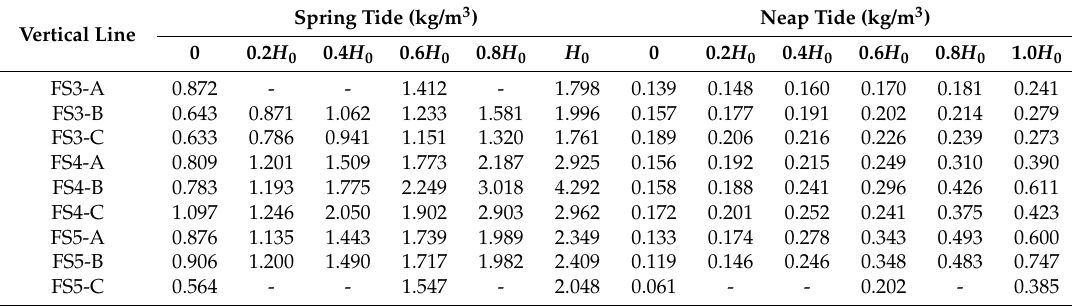
Table 3. Time-averaged sediment concentration ( S i ) along lines A, B and C during the wet season (2nd half of June 2015).